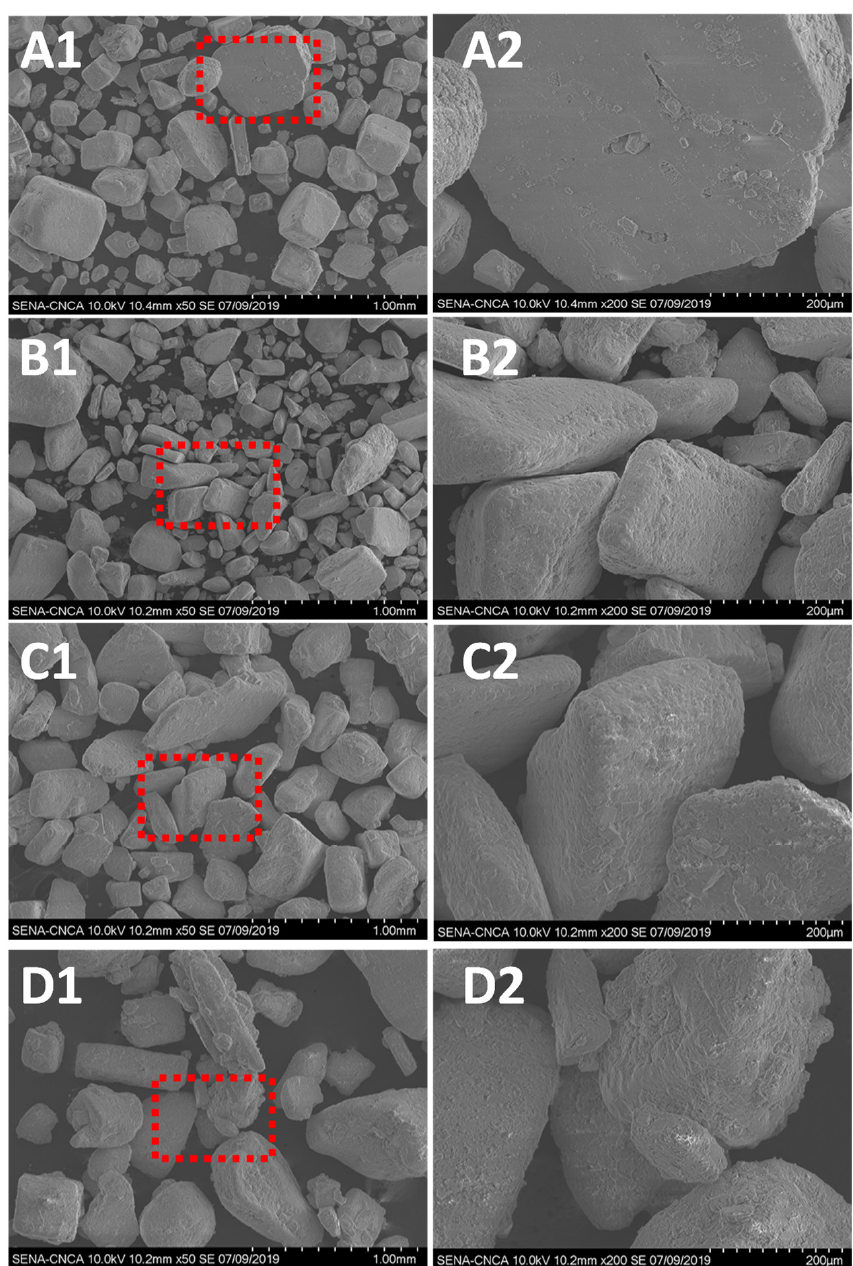
Figure 2. SEM images of sylvite samples from different deposits. Images were taken at ×50 and ×200 at 10.0 kV. Samples analyzed were ( A1 ): Blanco, ( B1 ): Problema, ( C1 ): BPC and ( D1 ): Bueno, at ×50. Images ( A2 ), ( B2 ), ( C2 ) and ( D2 ) correspond to the area marked with red dotted lines in the images of ( A1 ), ( B1 ), ( C1 ) and ( D1 ), respectively, at ×200.